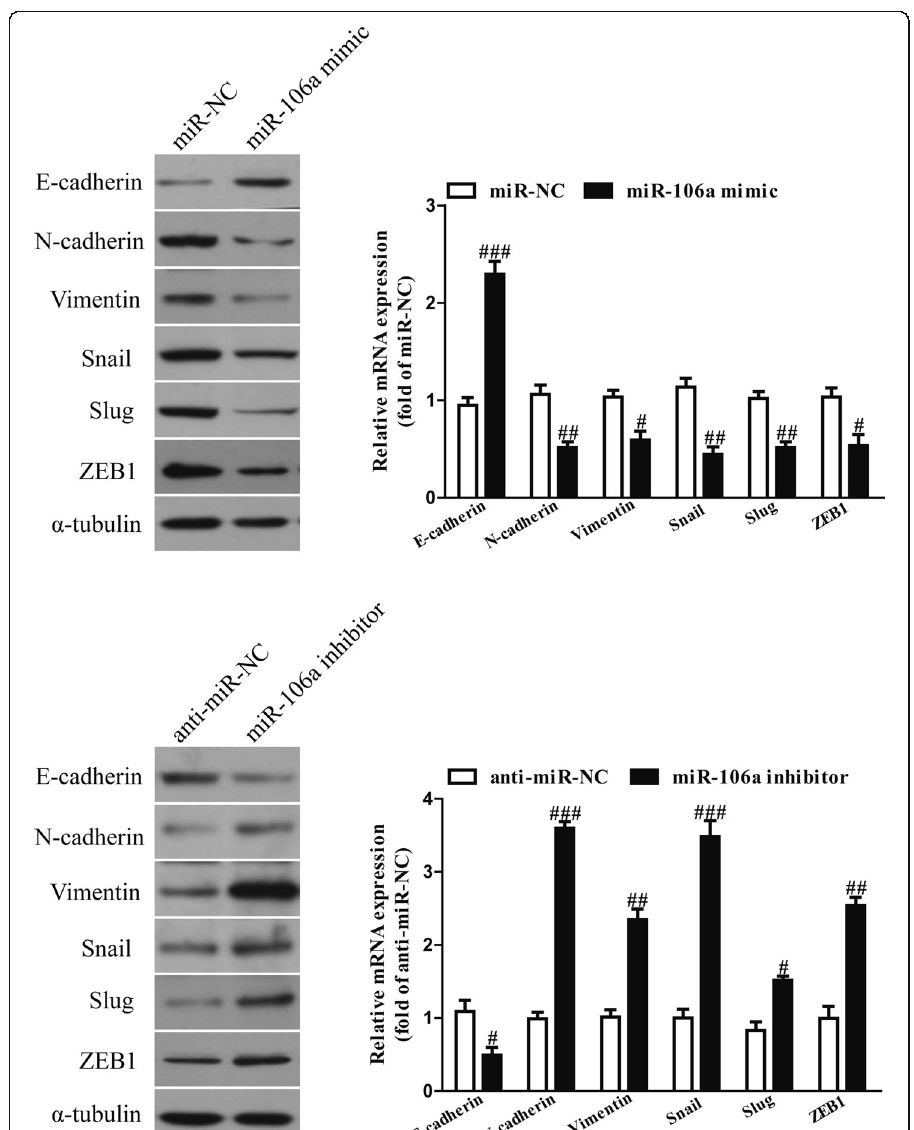
Fig. 5 The effects of miR-106a on the expressions of EMT-related molecules in OSCC cells. SCC4 cells were transfected with an miR-106a mimic or inhibitor for 48 h. The mRNA and protein expressions of E-cadherin, N-cadherin, vimentin, SNAIL, SLUG and ZEB1 were determined via quantitative RT-PCR and western blot, respectively. All data are presented as means ± SEM, n = 6. # p < 0.05, ## p < 0.01, ### p < 0.001 vs. miR-NC or